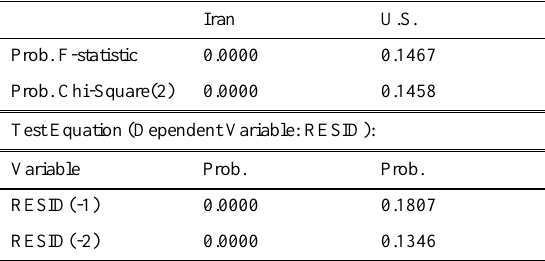
Table 3: Table 3: Serial Correlation Test on Daily Returns